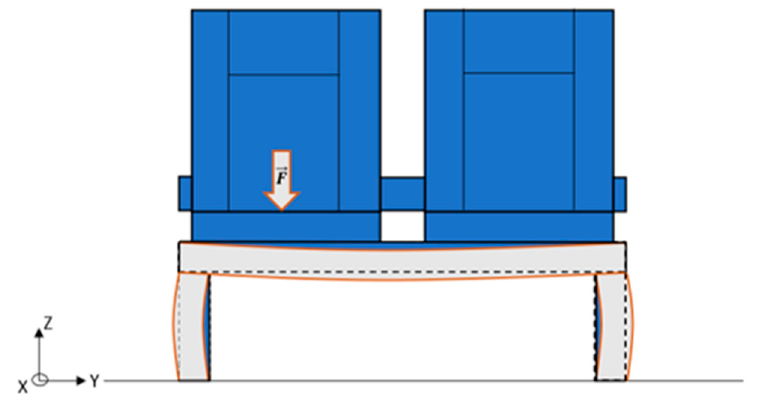
Figure 10. Demonstration of seat bending movement.